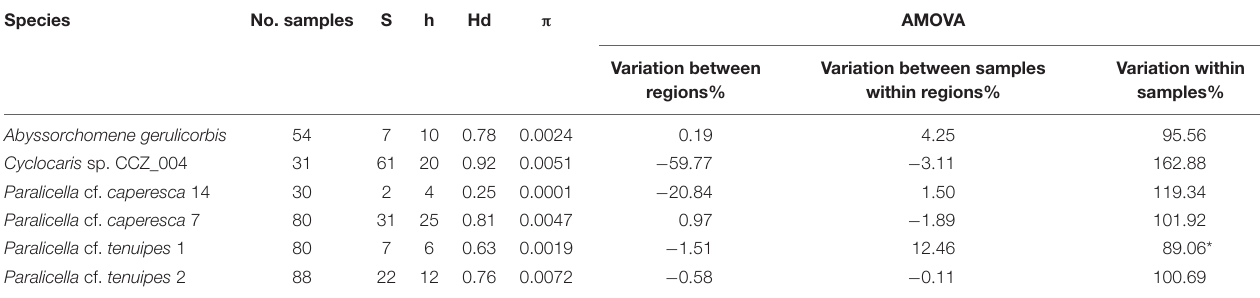
Paralicella cf. tenuipes 2 Number of samples per species, number of segregating sites (S), number of haplotypes (h), haplotype diversity (Hd), and nucleotide diversity ( π ) are given for each species, as well as the percentage of variation explained between regions, between samples within regions, and within samples as estimated from the analysis of molecular variance (AMOVA). *Monte-Carlo tests p <